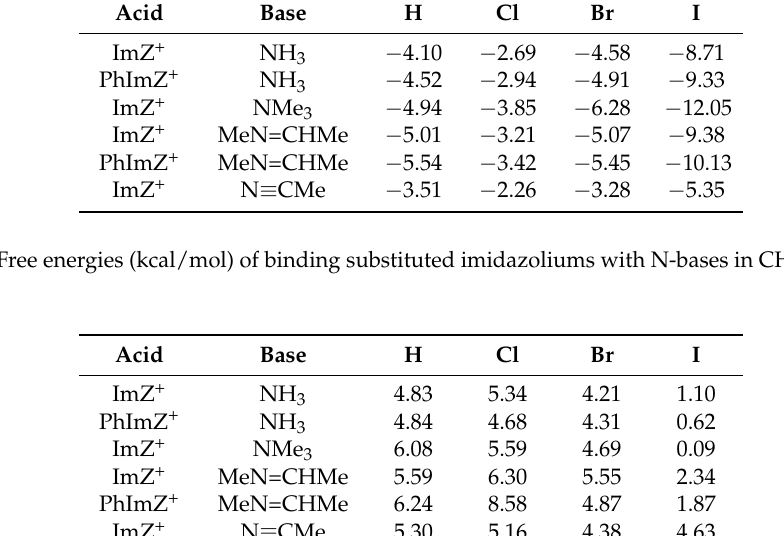
Table 3. Binding energies (kcal/mol) of substituted imidazoliums with N-bases in CH 2 Cl 2 solvent. Acid